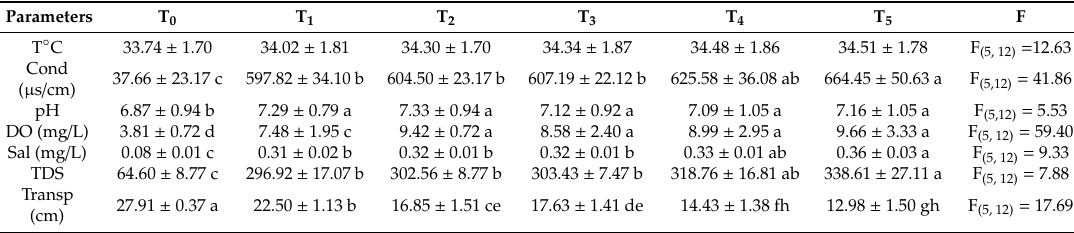
Table 1. Physico-chemical parameters of the di ff erent